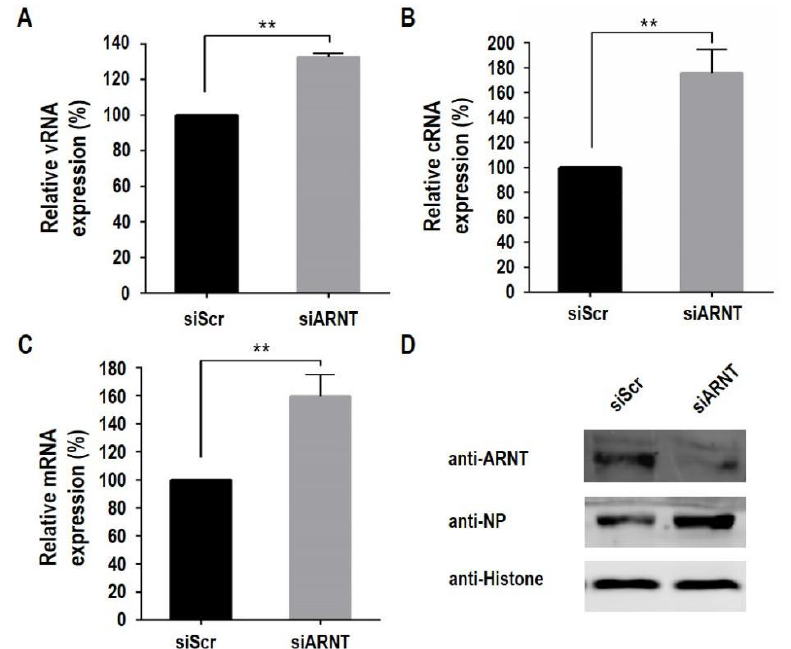
Figure 5. The effect of ARNT on viral genome replication and transcription. HeLa cells treated with ARNT-specific siRNA (siARNT) and non-targeting siRNA (siScr) were infected with GS/65 virus at an MOI of 2. At 8 h p.i., the RNA was extracted, and then the expression levels of vRNA ( A ), cRNA ( B ), and mRNA ( C ) of the NP gene were determined by using qRT-PCR. Nuclear proteins were extracted for Western blot analysis ( D ). ** p < 0.01.